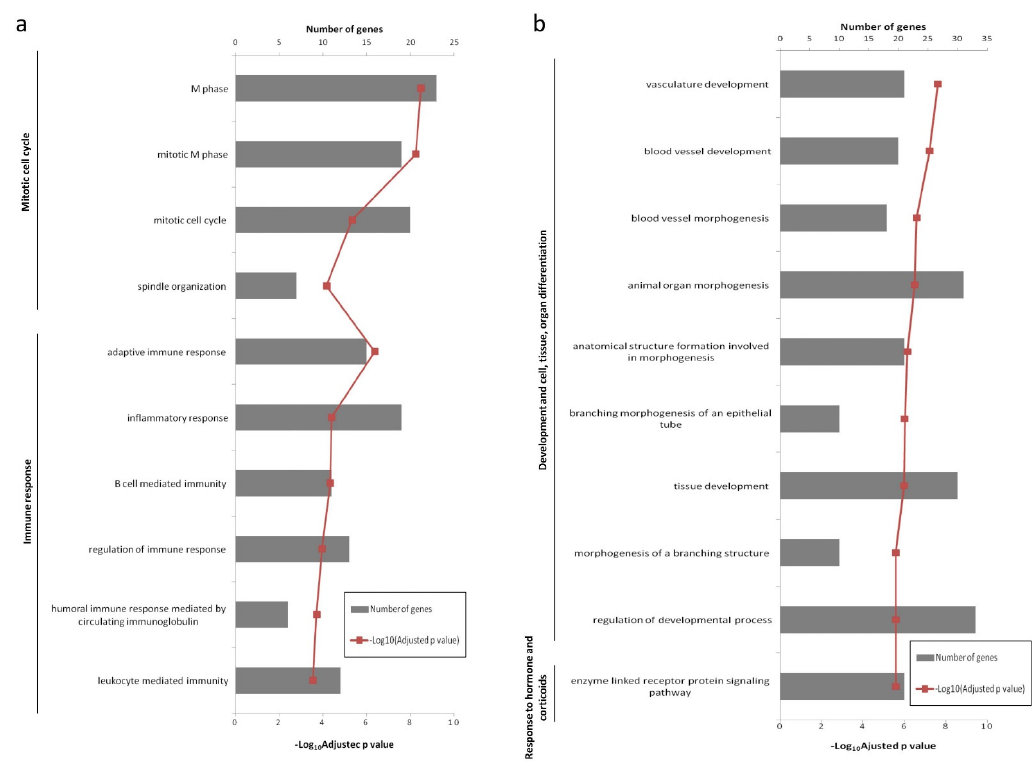
Figure 4. The Top 10 significant enriched GO terms in the Lesions group relative to the Asymptomatic group. ( a ) Up-regulated genes ( b ) Down-regulated genes.